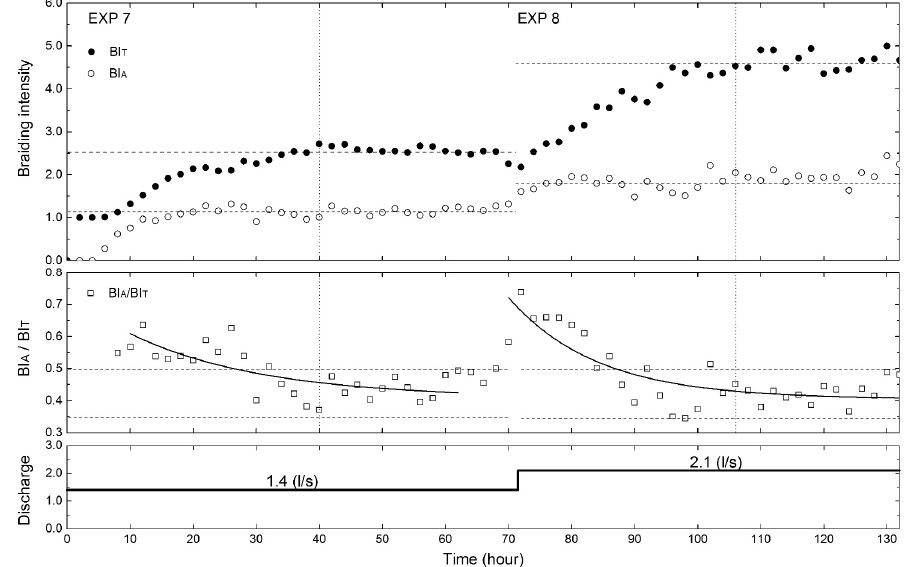
Figure 9. Variations in total braiding intensity (BI T ), active braiding intensity (BI A ), and BI A /BI T during sequential flow stages. Table 2. The braiding intensities of the model predicted river and the experimental river.